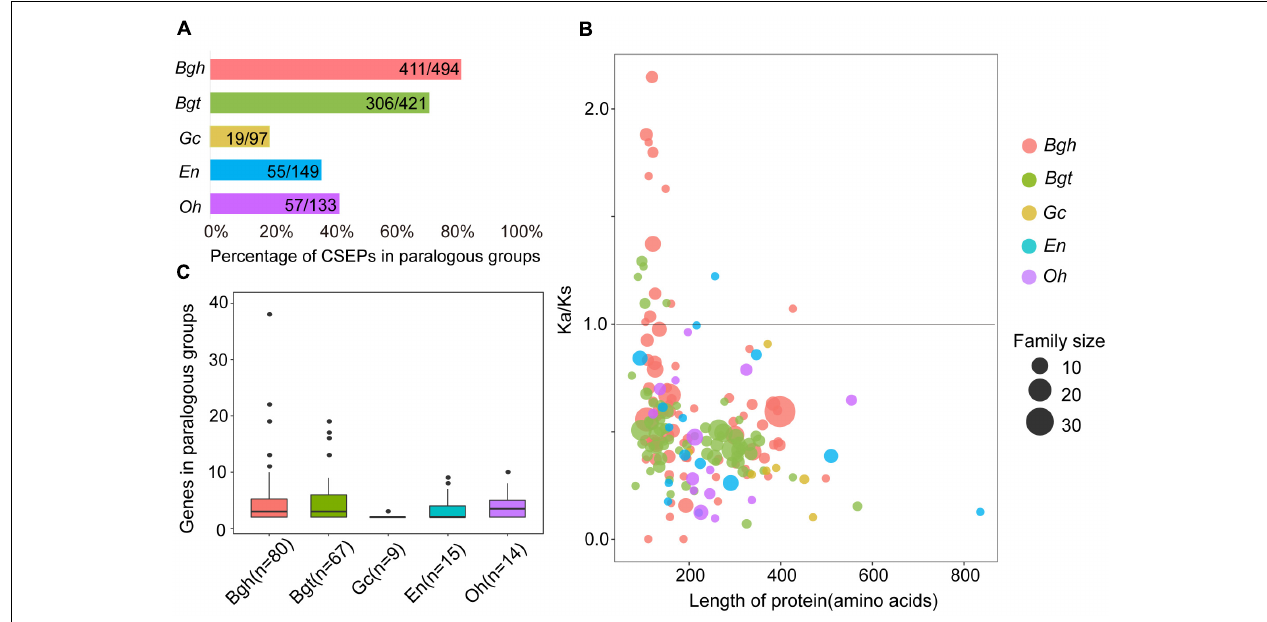
FIGURE 6 | Comparison of CSEP paralogs shows fewer families and purifying selection in dicot powdery mildews and more families and positive selection in monocot powdery mildews. (A) Percentage of CSEPs in paralogous families. (B) Gene number for CSEP paralogous families. (C) K a/ K s within all paralogous CSEP families plotted versus protein length. K a/ K s values were calculated as averages of each pairwise gene in the family. Circles sizes indicate genes numbers for relative families. Circle colors indicate different powdery mildew